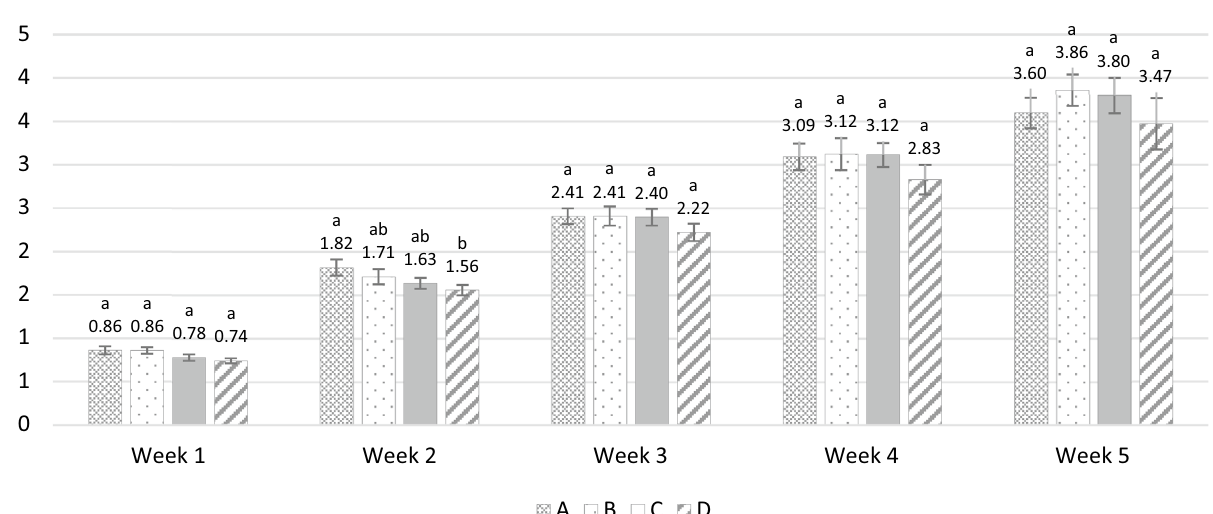
Figure 7. Weekly average percentage change in weight of the overall mangoes exposed to various treatments ± SE ( A negative control non-treated fruit; B PJ-WS-LE extract at 8 g L −1 was used to treat the